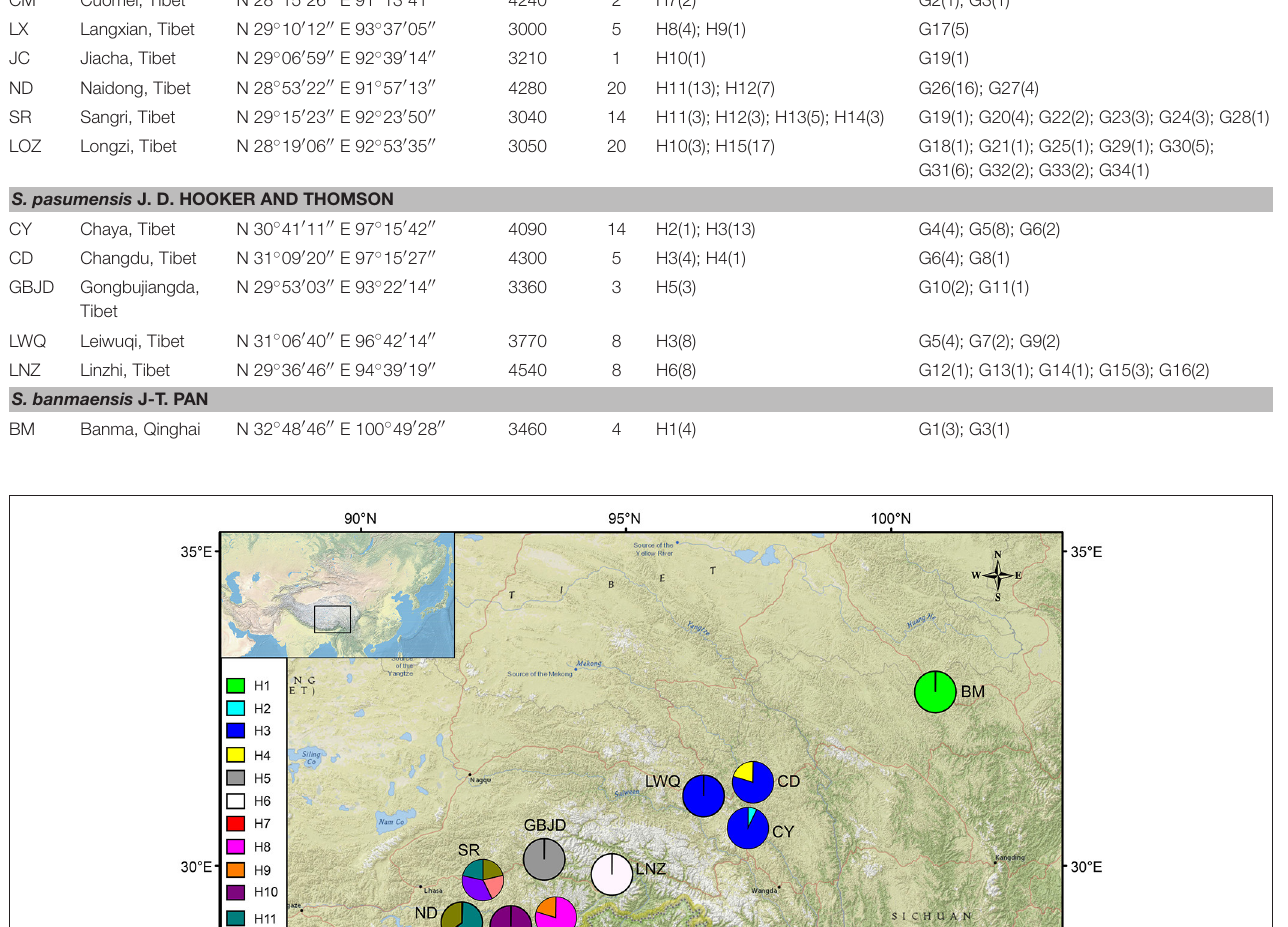
TABLE 1 | Population code (Pop.), sampling location, coordinates, altitude, number of investigated individuals ( n ), cpDNA haplotype and ITS genotype composition of investigated populations of Saxifraga umbellulata , S. pasumensis and S. banmaensis. Pop . Location Coordinates Altitude (m) n Haplotype/genotype composition cpDNA ITS